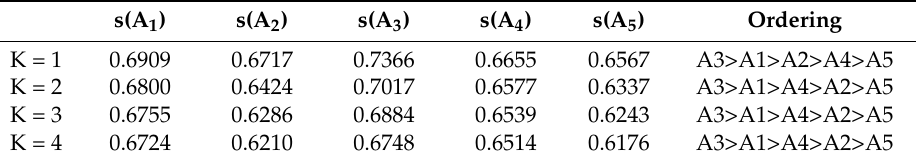
Table 5. Ranking results for different operational parameters of the IV2TLPFWMSM operator.